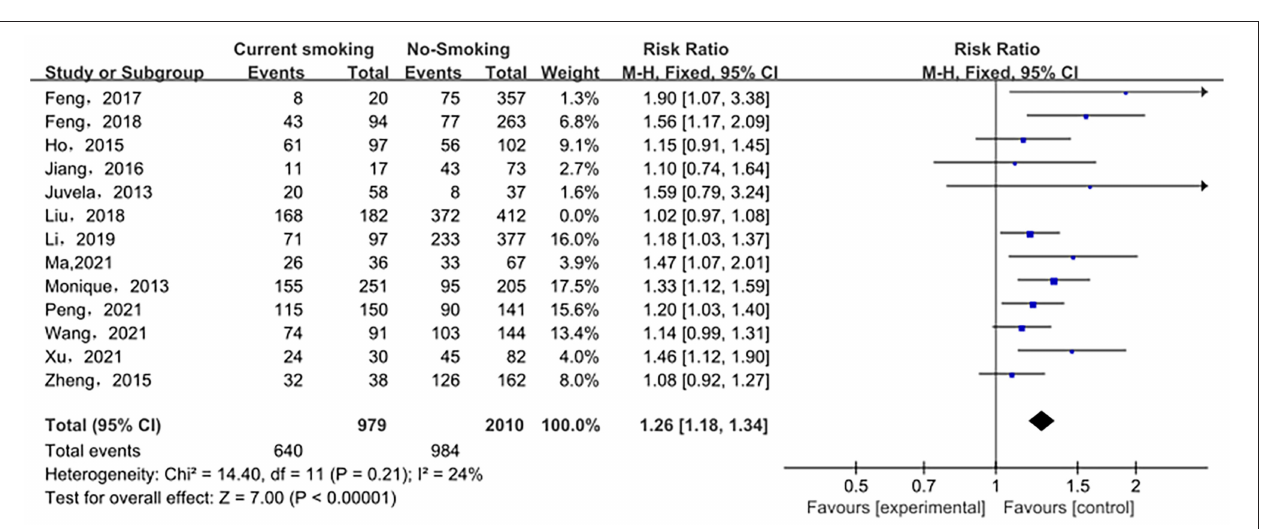
FIGURE 5 | A Forest plot of the current smoking and non-smoking groups after heterogeneous cohorts were removed by sensitivity analysis.